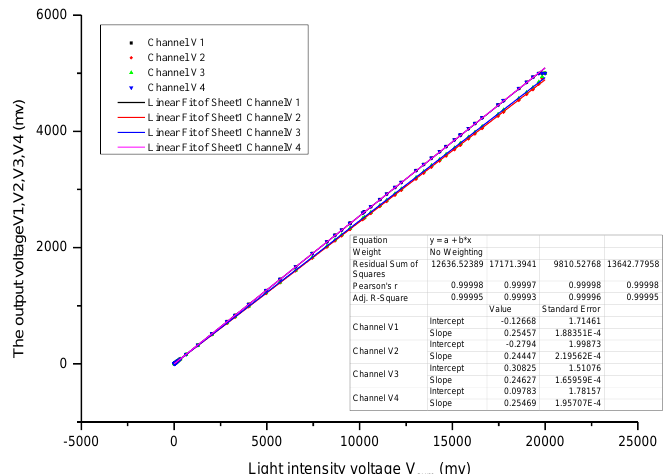
Figure 13. The fitting curve of 4 channel output voltages at PSD center point.